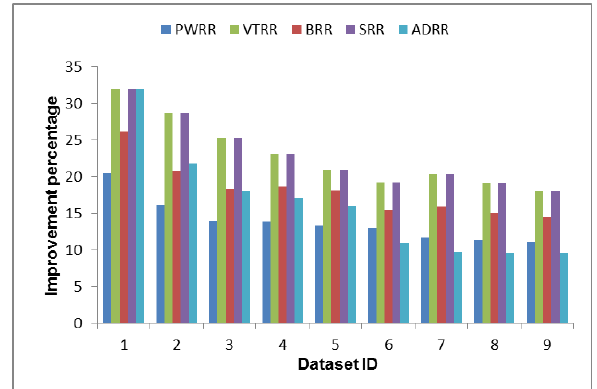
Figure 6. Improvement percentage of the proposed algorithm over the compared algorithms.